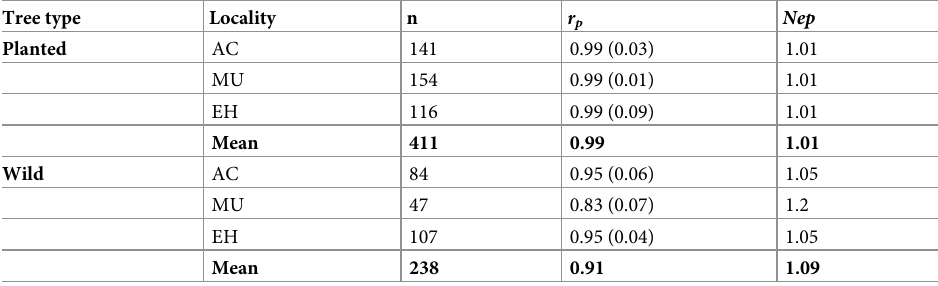
Table 3. Paternity correlation of wild and planted stands of Spondias purpurea . Tree